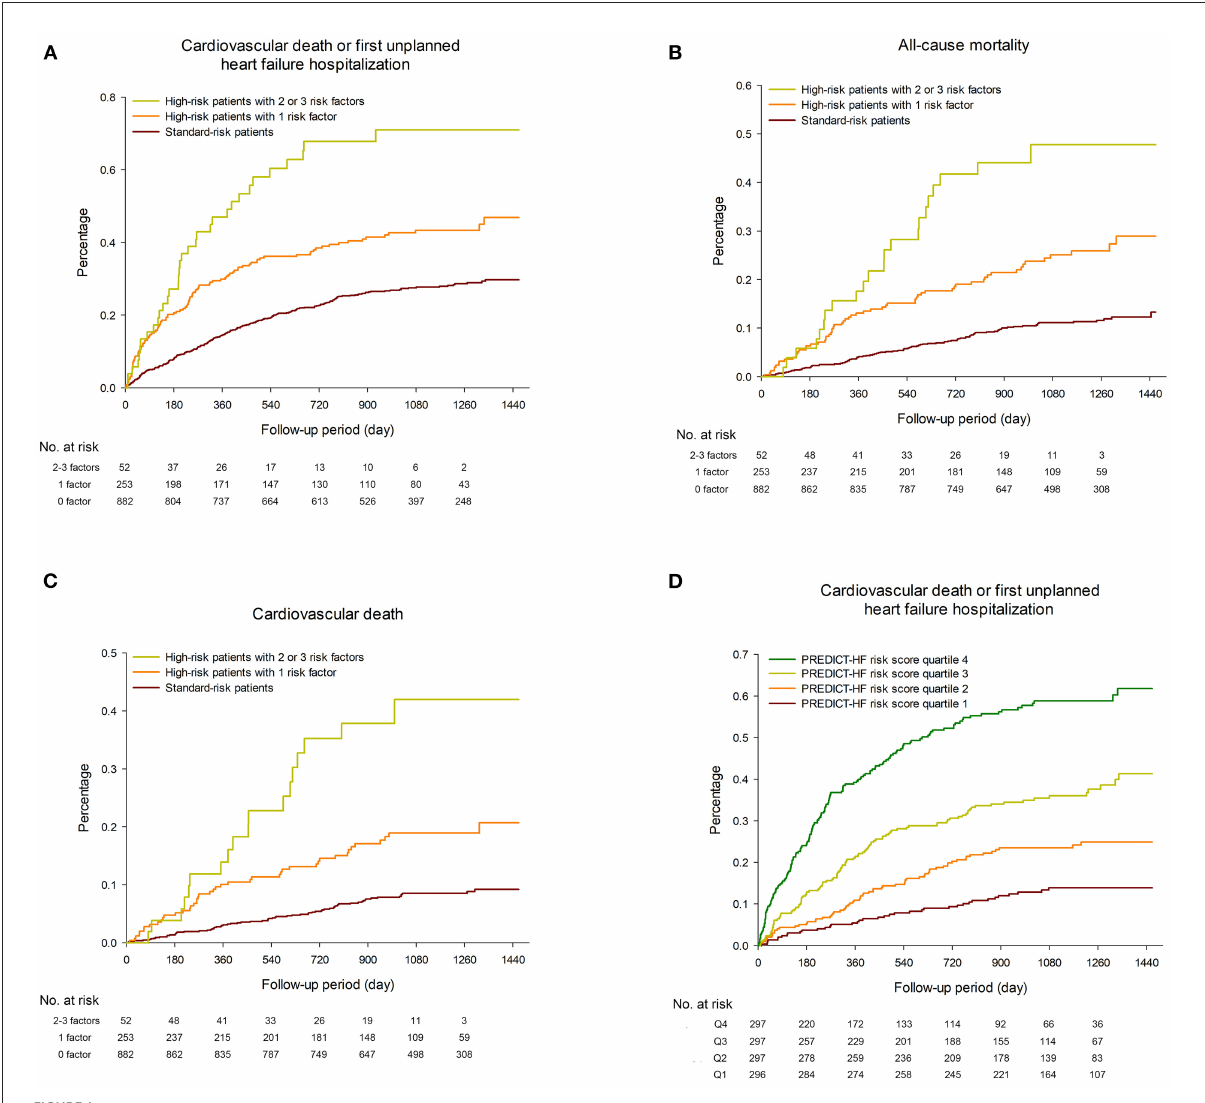
FIGURE1 Kaplan–Meier survival curves for (A) cardiovascular death or first unplanned heart failure hospitalization (HFH), (B) all-cause mortality and (C) cardiovascular death among the study population, stratified by different risk groups. (D) Kaplan–Meier plots of the observed event rate in the TAROT-CHF cohort for clinical outcomes, categorized by quartile of PREDICT-HF risk